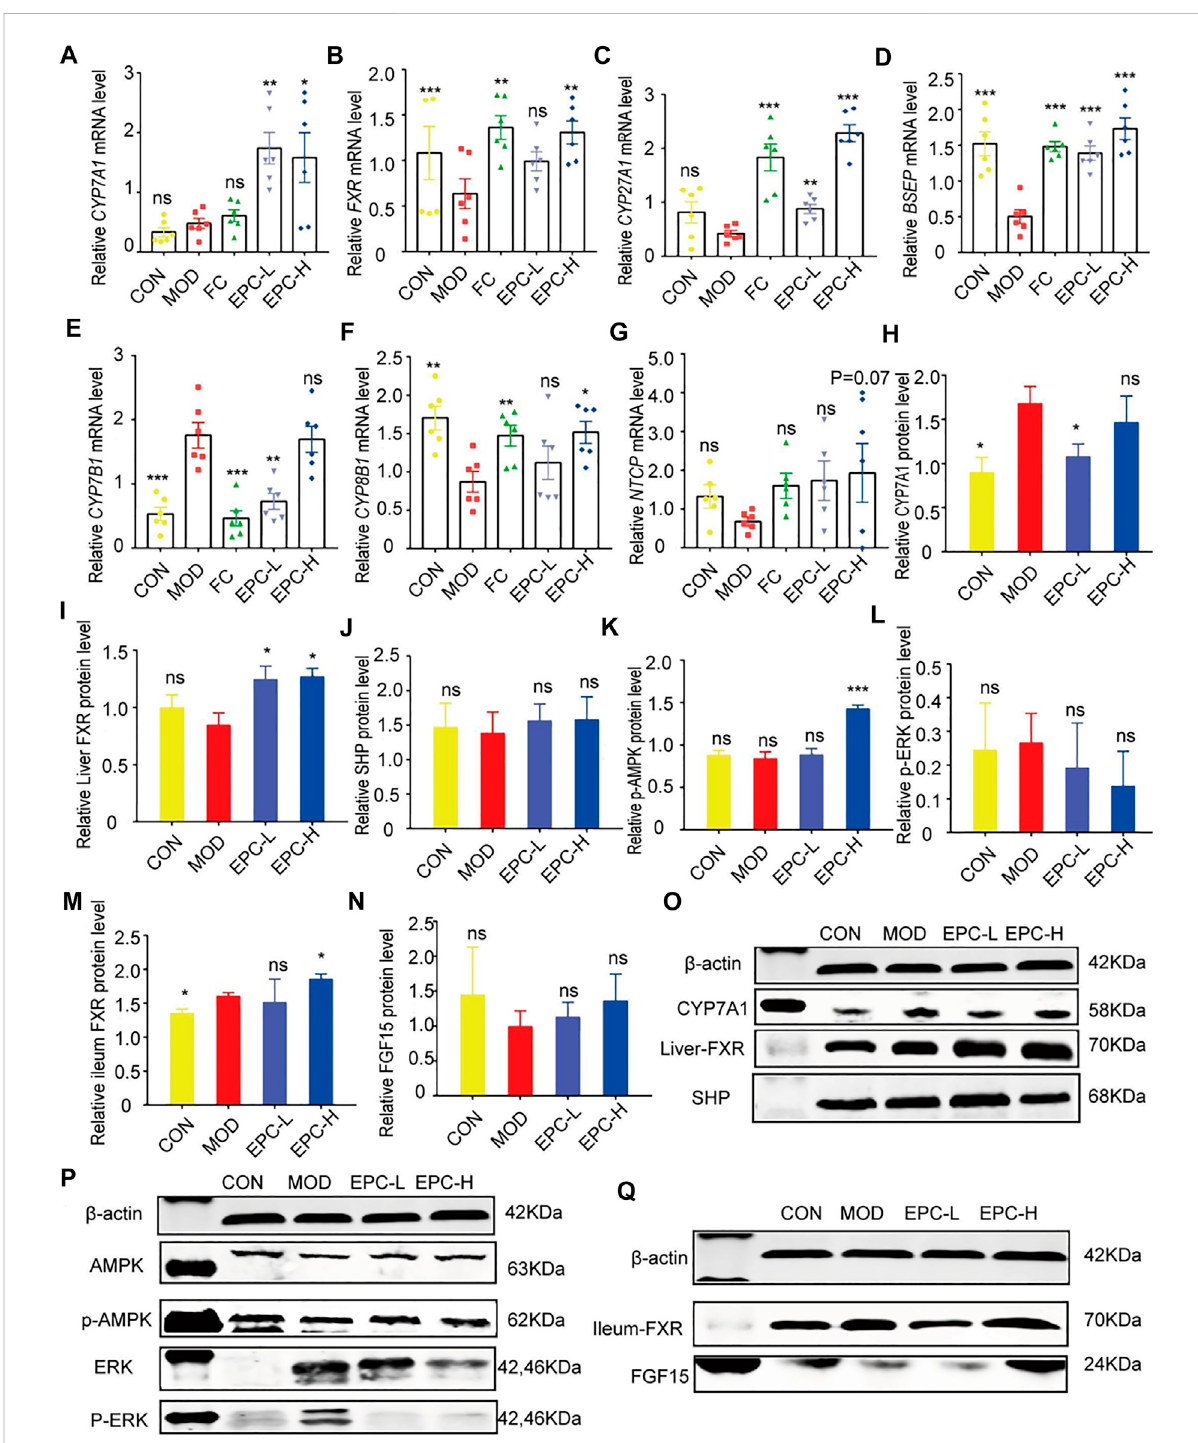
EPC ameliorated MAFLD formation in rats by regulating BA metabolism. (A – G) Relative expression of CYP7A1 , FXR , CYP27A1, BSEP , CYP7B1, CYP8B1, NTCP mRNA in liver, n = 6 ; (H – L) Relative expression of protein CYP7A1, FXR, SHP, p-AMPK, and p-ERK in the liver, n = 4; (M – N) Relative expression of protein FXR and FGF15 in the ileum, n = 4. (O – P) Representative immunoblotting images of CYP7A1, FXR, SHP, p-AMPK,and p-ERK in the liver. (Q) Representative immunoblotting images of FXR and FGF15 in the ileum. Data are presented as mean ±SEM. One-way analysis of variance (ANOVA)wasconductedforthegroup comparison. * p < 0.05, ** p < 0.01,*** p < 0.001 vs MODgroup. CYP7A1,cholesterol 7 α -hydroxylase; FXR, farnesoid X receptor; CYP27A1, sterol 27-hydroxylase; BSEP, bile salt export protein; CYP7B1, oxysterol 7 α -hydroxylase; CYP8B1, sterol 12 α